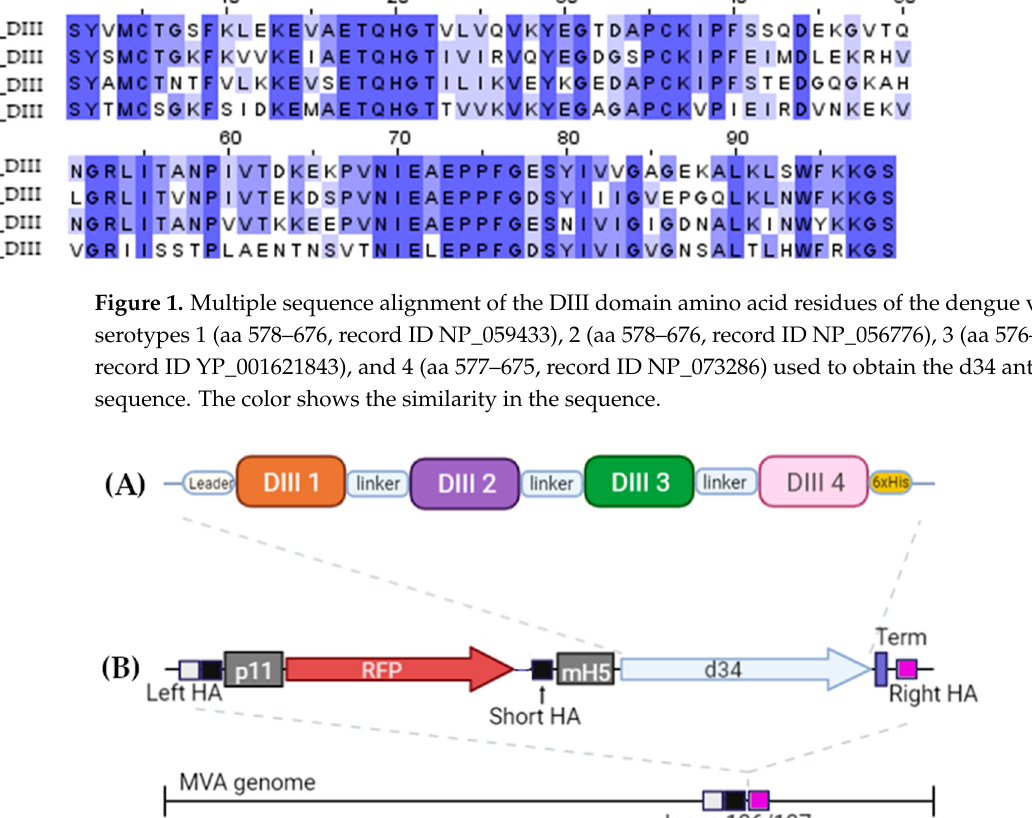
Figure 2. Schematic of the structure ( A ) of the antigen d34 and ( B ) expression cassette located in the MVA genome. Leader—the mouse Igk leader; linker—2x(GGGGS). The light box with the black box is the left homology arm (Left HA), the black box is the short left homology arm (Short HA), and the pink box is the right homology arm (Right HA). Gray boxes represent p11 and mH5 promoters from the vaccinia virus, driving the expression of RFP and d34 antigens, respectively. Vaccinia virus termination signal TTTTTNT (labeled as Term on the scheme) was used for stopping the transcription of RFP and d34 ORFs. More details can be found in Section 2.2.